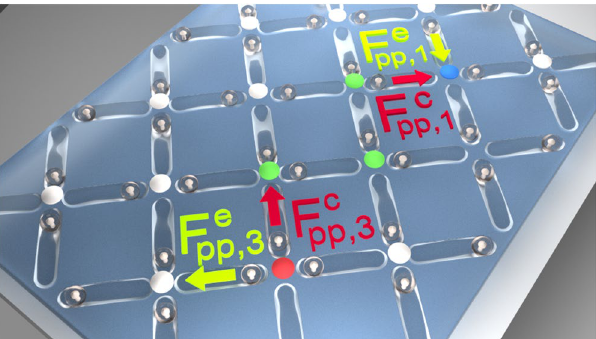
Figure 3. Schematic showing the forces that are responsible for contracting and extending the defect line. The 1-in and 3-in ends of the line are marked blue and red, respectively, while the biased ground state vertices along the defect line are marked green. Particle-particle forces that act to extend (e, green lettering and arrows) or contract (c, red lettering and arrows) the defect are marked for the 1-in end, F ppe F ppe ,3 , F ppc ,3